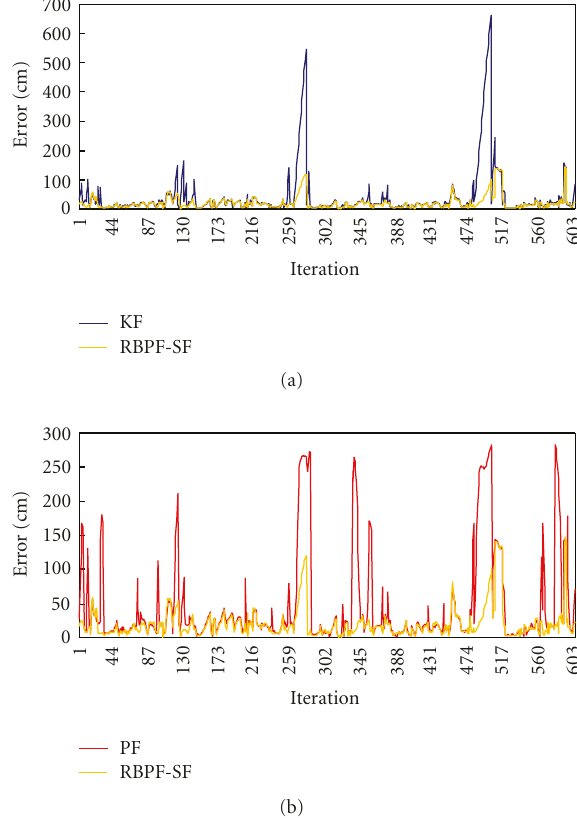
Figure 13: Comparisons of tracking errors among KF, PF, and